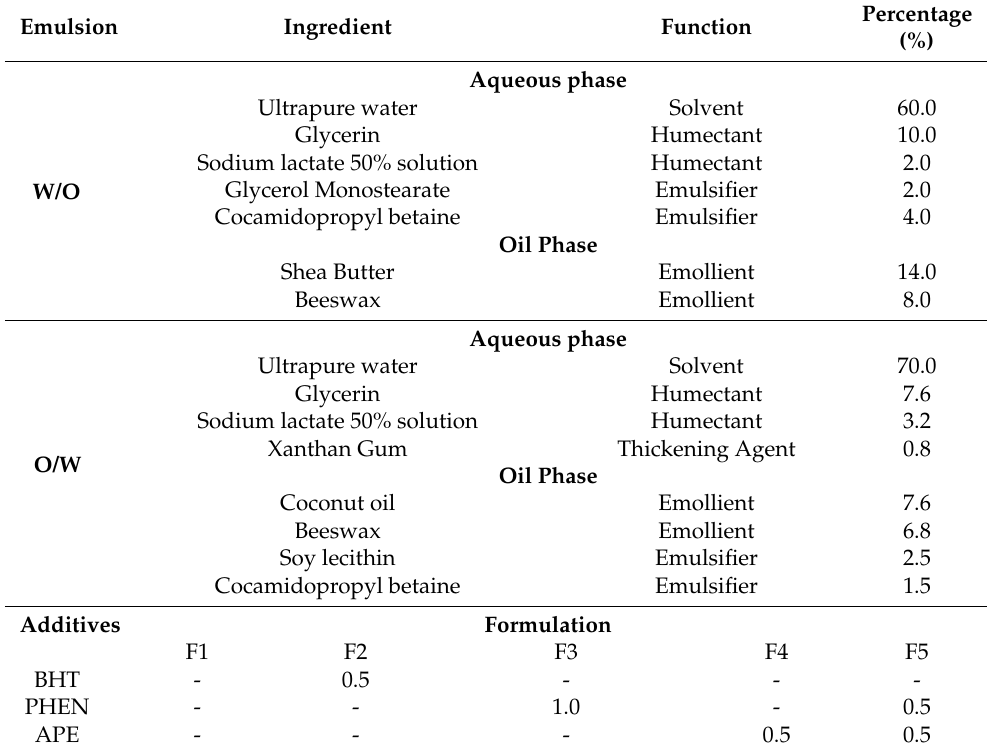
Table 4. Composition of the base formulation (F1) of the two emulsions, with the respective function and percentage of the